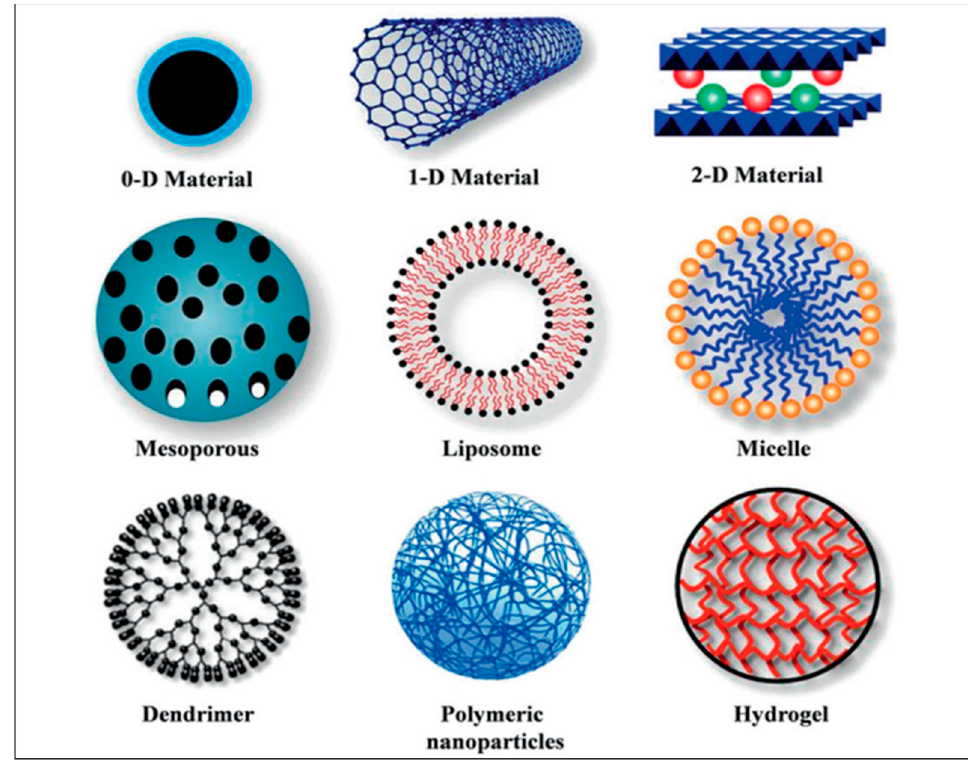
Figure 1. Classes of nanoparticles. Each subclass consists of unique properties for drug delivery research. (Reproduced from Ref. [33] with permission from Nature.)